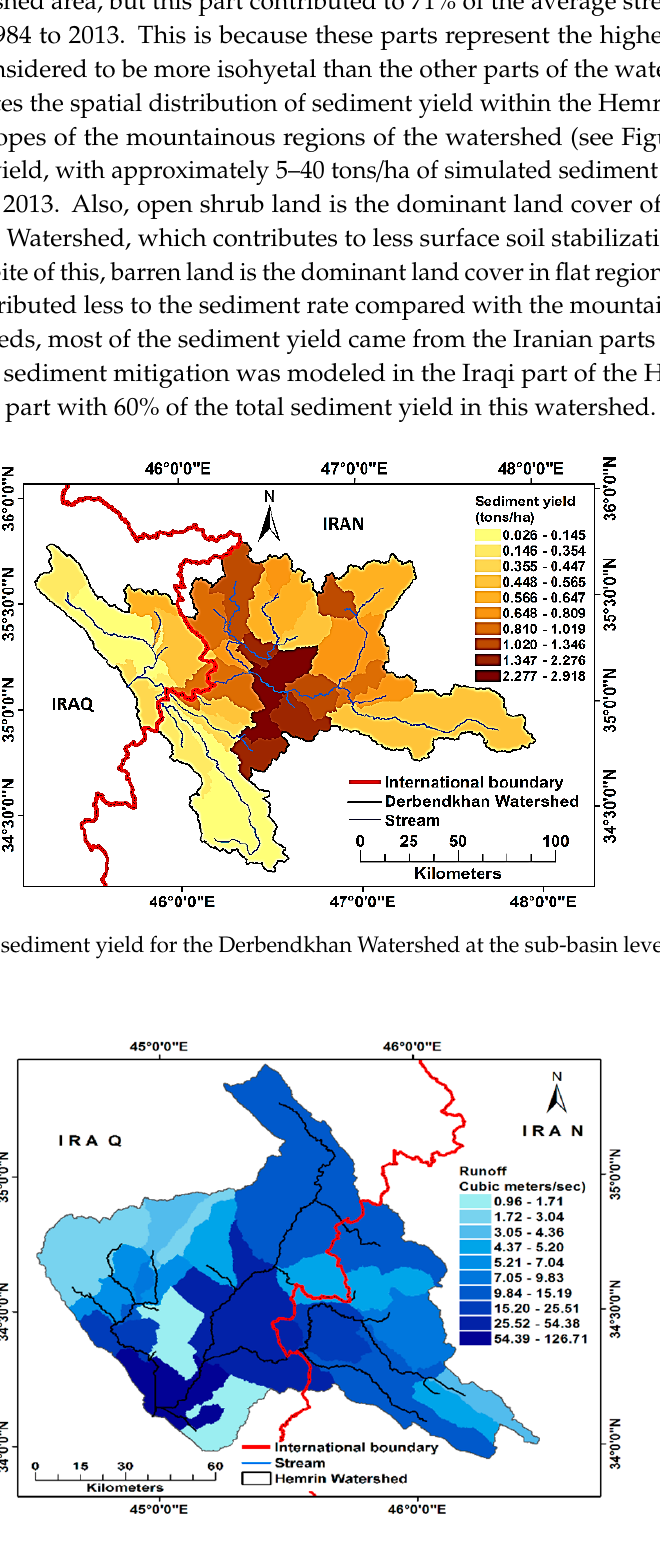
Figure 19. Average sediment yield at the sub-basin level for the period from 1984 to 2013 for the Hemrin Watershed. 3.6. Mitigation of Sediment Yield According to the future prediction of water resources in the Diyala River based on the conditions, it is necessary to maintain the quantity and quality of water in the Diyala River. Therefore, some conventional sediment yield mitigation techniques were applied in the most